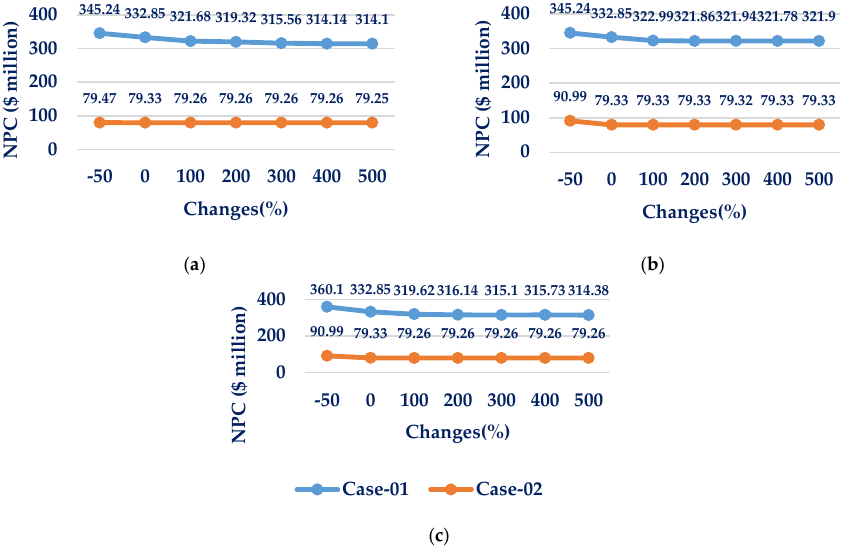
Figure 27. Impact on NPC due to variation in ( a ) PV panels availability; ( b ) WT availability; ( c ) both.